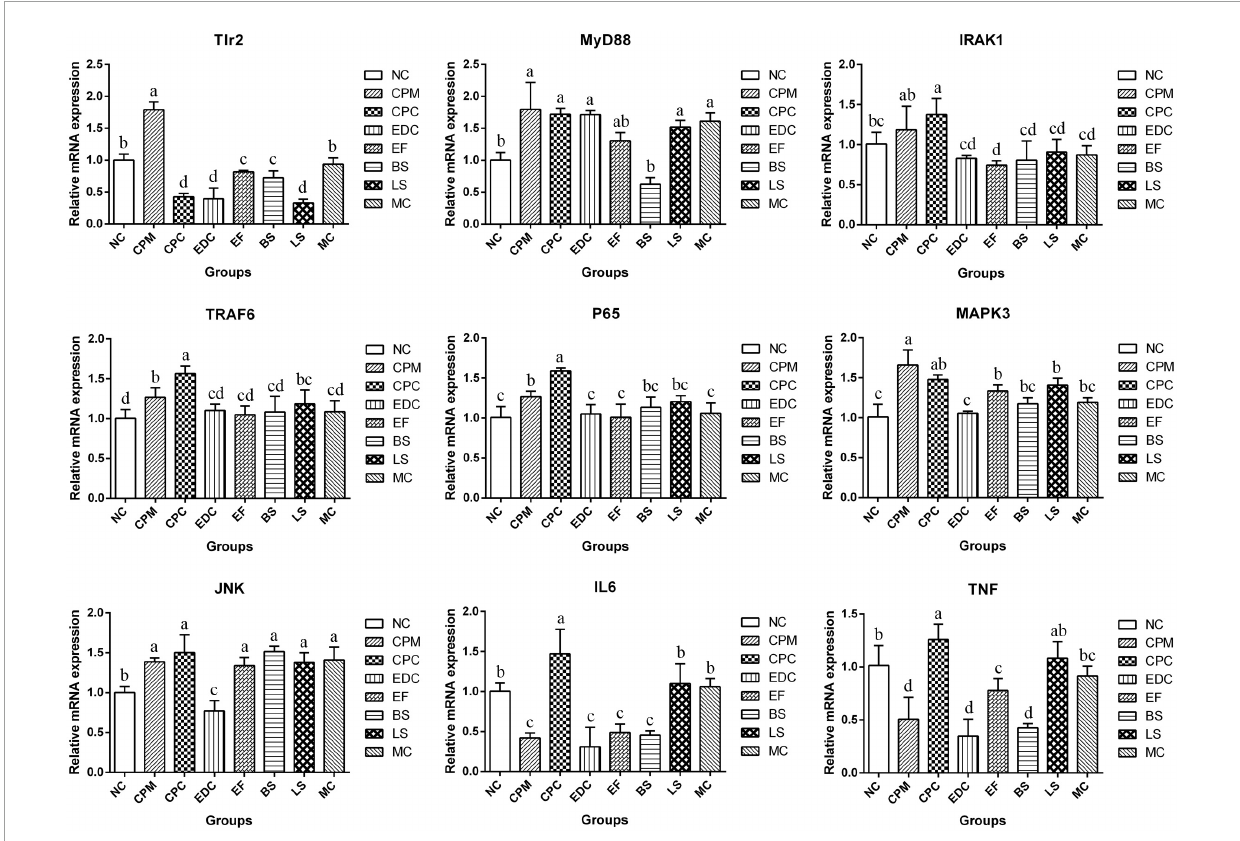
FIGURE8 Expression of TLR2/NF- κ B and TLR2/MAPK signaling pathway related genes in ileum after different treatments ( n = 6). Data represent mean values ± SEM. a, b Means with different superscripts within a row were significantly different ( P <